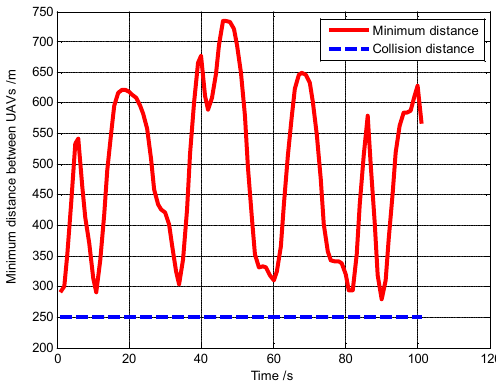
Figure 32. The minimum distance between the UAVs during the whole simulation process (Scenario 3). In Scenario 3, the average estimate errors, the average transmission probabilities, the average trace of the FIM are shown in Table 7.